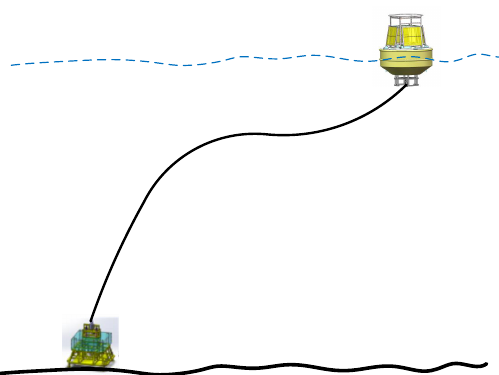
Figure 12. The approximate shape of the mooring line under extreme sea conditions. J. Mar. Sci. Eng. 2020 , 8 , x FOR PEER REVIEW